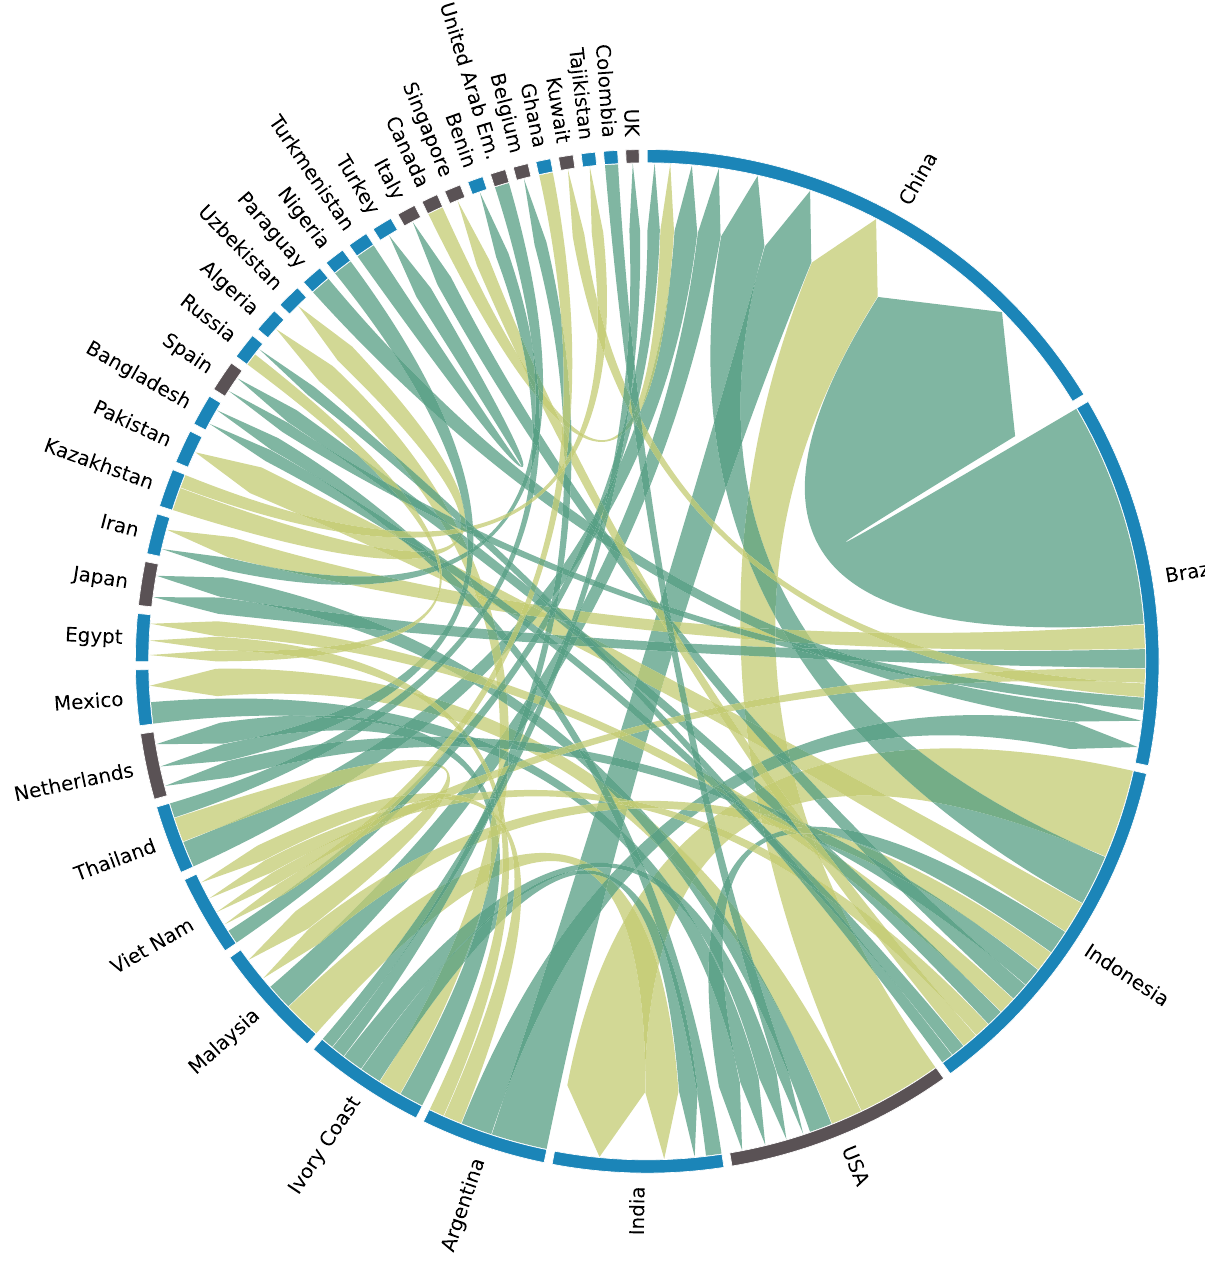
Figure 4. Largest 50 scarcity-weighted VW fluxes (CWSI-weighted m3). The flux flows in the direction of the arrow. Unfair fluxes (fluxes for which the exporter country has a higher composite scarcity index than the importer) are coloured in dark green; fair fluxes are in light green. High-income countries are in black; low-and middle-income countries are in